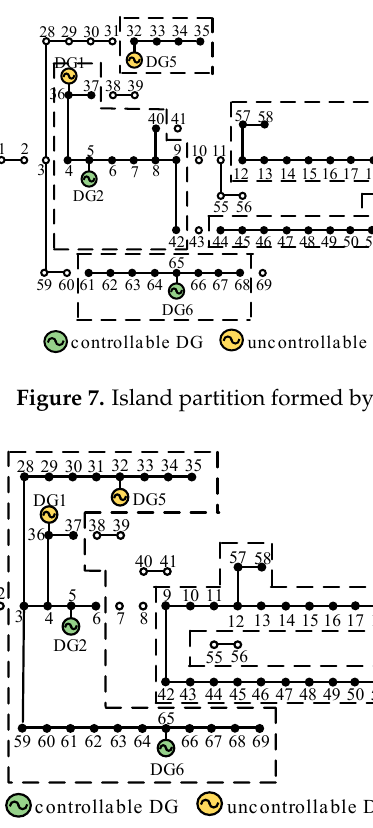
Figure 8. Island partition formed by the method in [22].